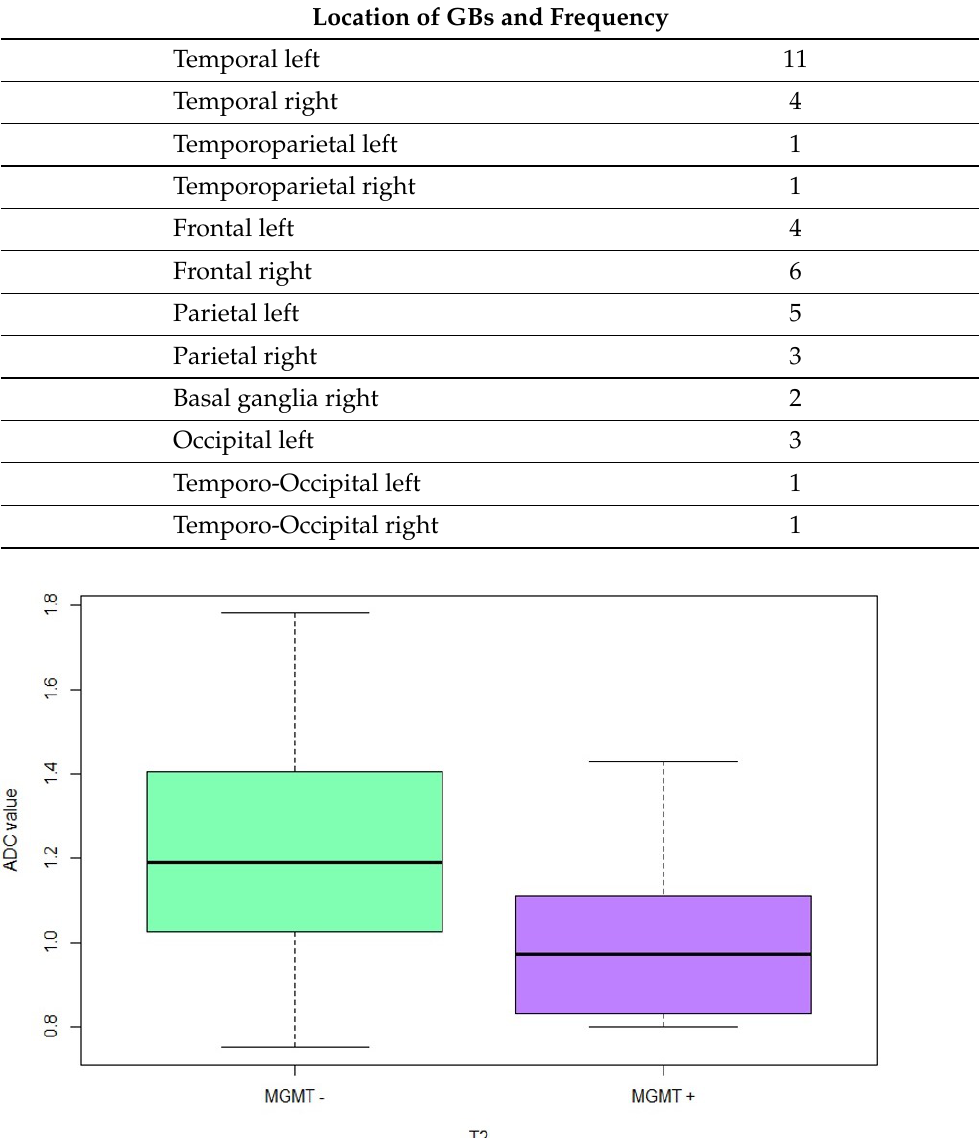
Table 2. Location of GBs and frequency.